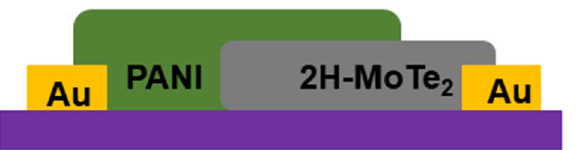
Figure 1. Schematic diagram of the layered heterostructured sensor device composed of 2H-MoTe 2 film and PANI film.